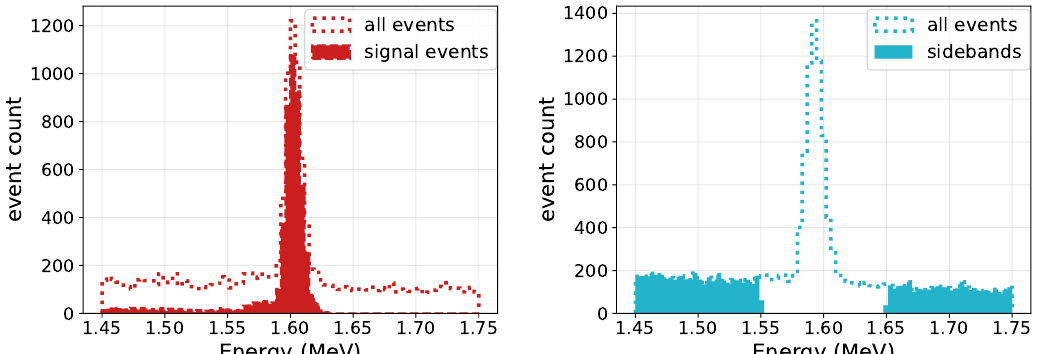
Figure 4 . Left: energy distribution of all MC events (dashed line histogram) and of chosen signal events (solid histogram). Right: energy distribution of experimental data events showing selected sideband events. The sidebands are 100 keV in width, with each band starting 45 keV from either side of the double escape peak. The same procedure is also used to select the sidebands in